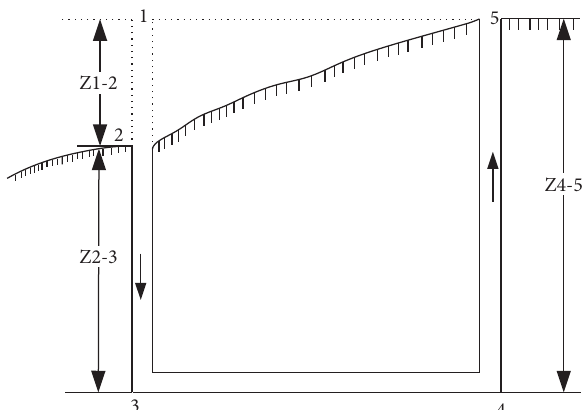
Figure 3: Schematic diagram of natural ventilation in